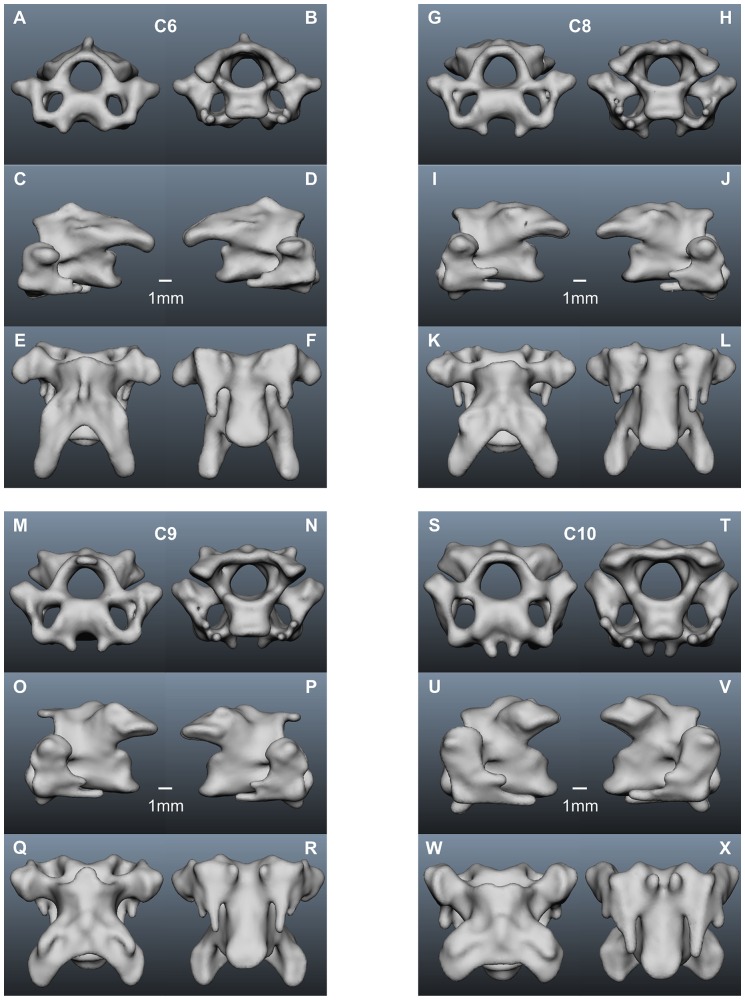
Cervical vertebrae of the American barn owl II.A–F) 6th cervical vertebra; G–L) 8th cervical vertebra; M–R) 9th cervical vertebra; S–X) 10th cervical vertebra. For further explanations see legends to Figures 1 and 6.